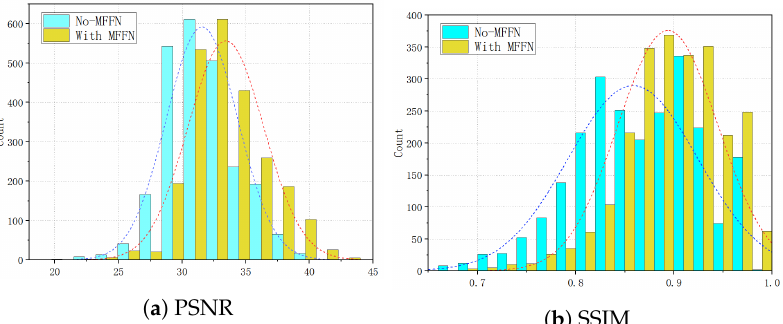
Figure 14. The distribution of PSNR and SSIM of our method with MFFN and without MFFN on the testing